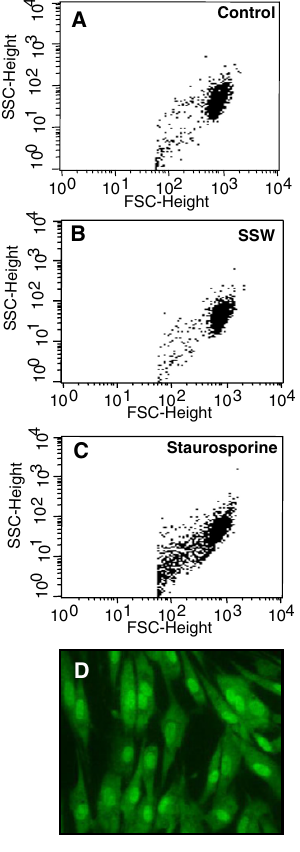
Figure 2 Flow cytometric analysis of cells treated with SSW smoke . Cells were treated with 1:9 SSW smoke or with staurosporine and analyzed by flow cytometry to determine the forward- and side-scattering properties of the